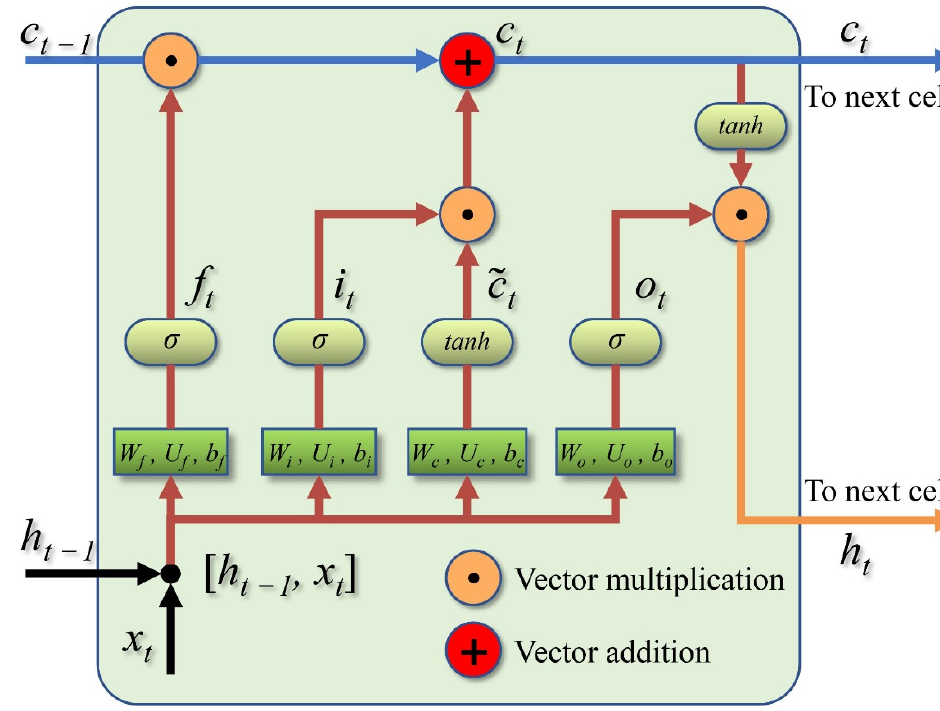
Figure 2. The detailed structure of LSTM.